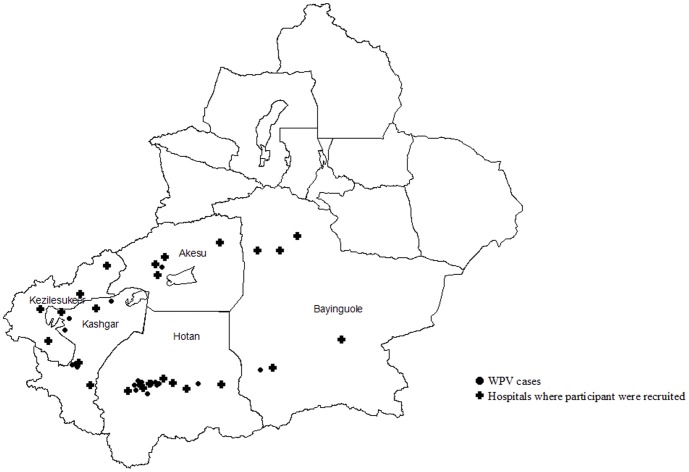
Distribution of WPV cases and hospitals in which blood specimens were collected in southern Xinjiang Uygur Autonomous Region.